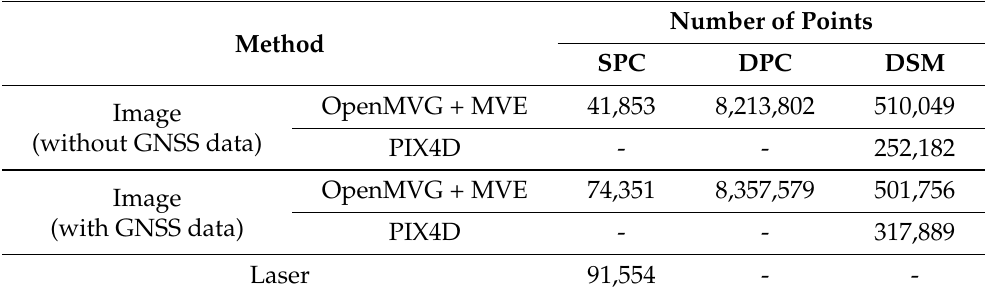
Table 3. Results of the 3D construction obtained from different methods and presented in terms of the number of points of three distinct models: number of points of the Sparse Point Cloud (SPC), Dense Point Cloud (DPC), and Digital Surface Model (DSM) or